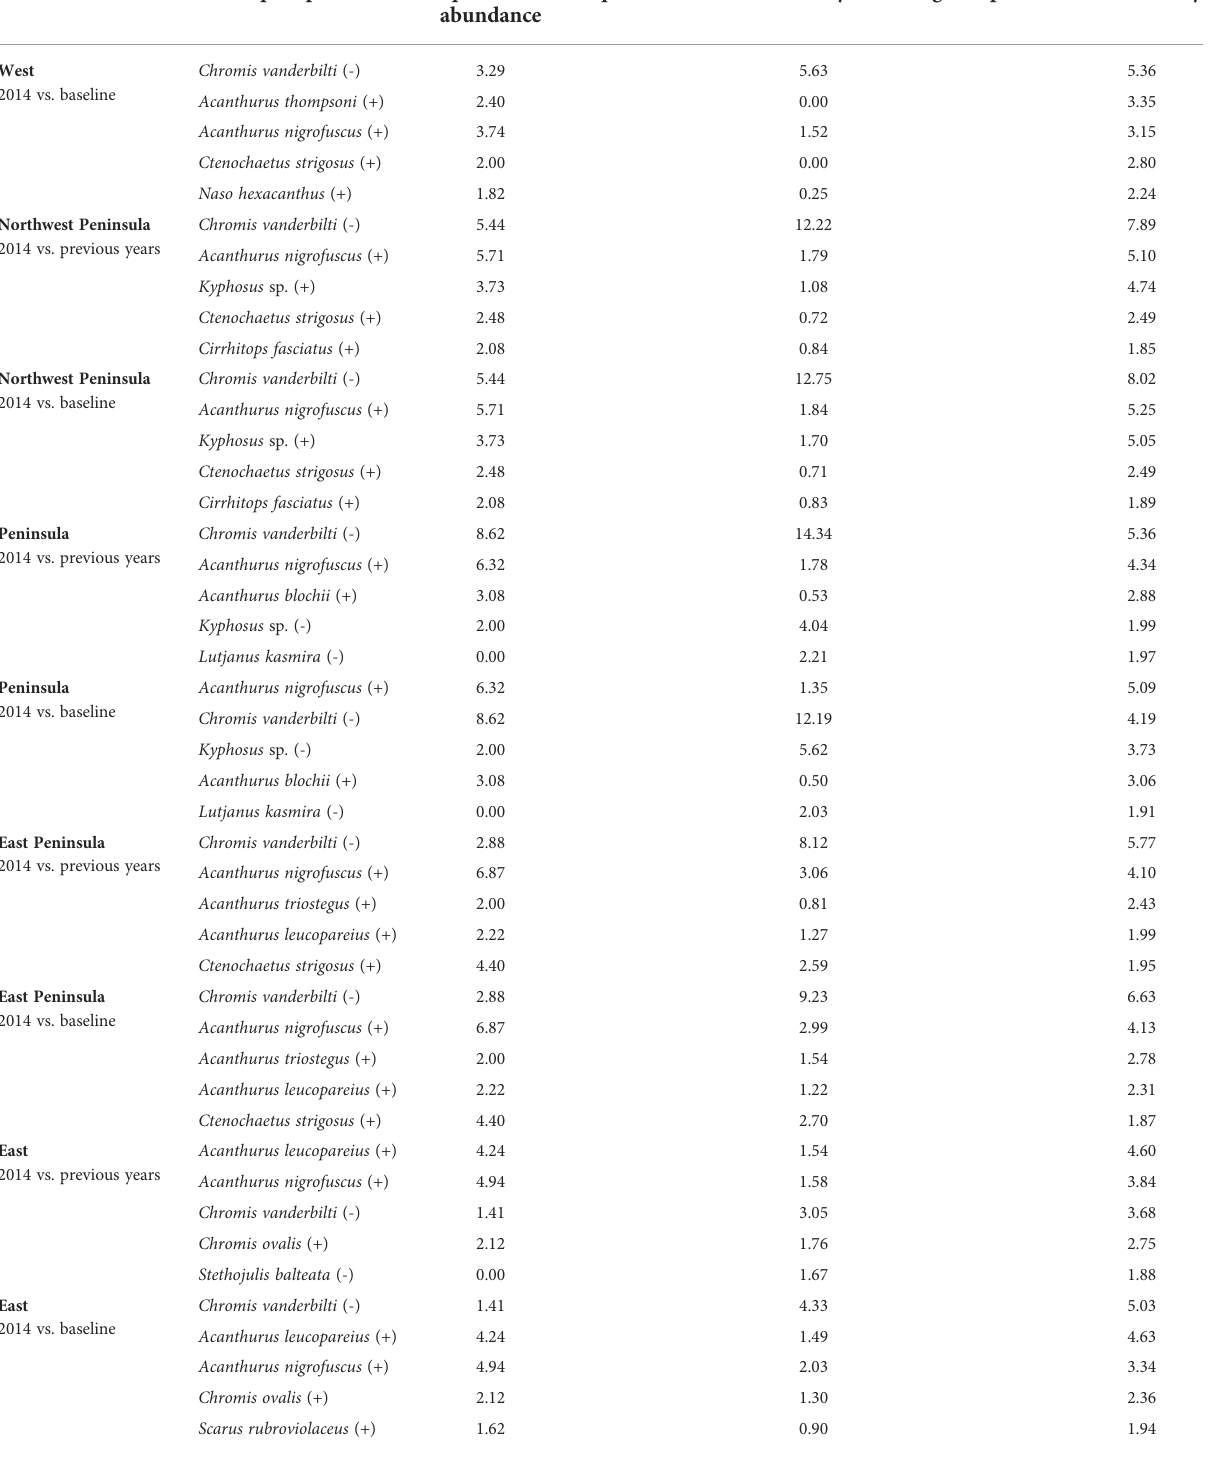
TABLE 5 Results of SIMPER analysis showing the top fi ve species that contributed to separating fi sh assemblages of KALA in 2014 years as identi fi ed by MCCs. Top 5 species Square-root Square-root abundance in years being compared Dissimilarity abundance West 2014 vs.